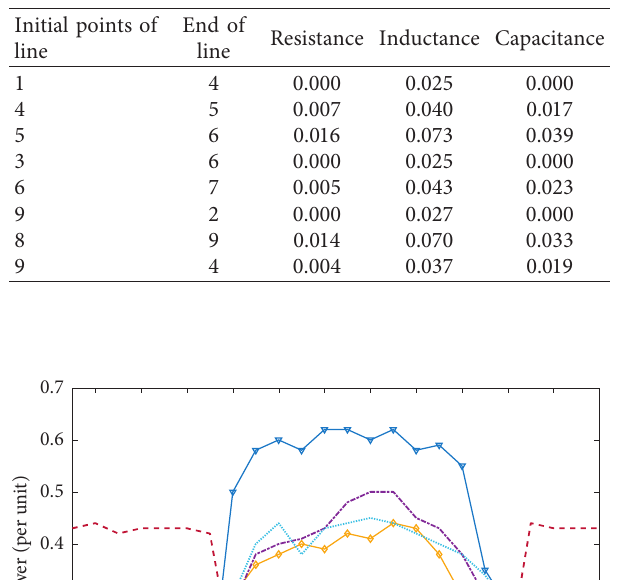
Figure 2: Topology of multienergy complementary microgrid system. Table 1: Line parameter.